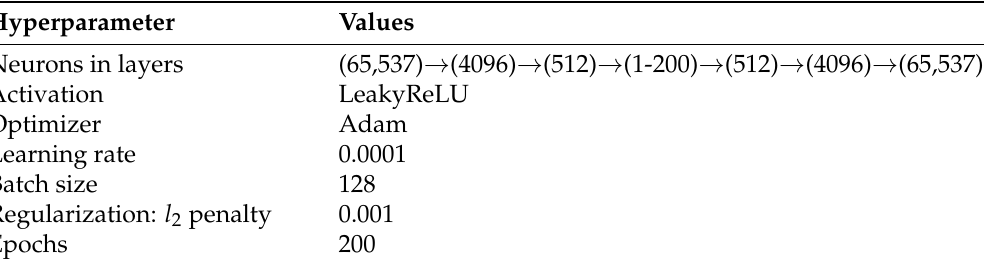
Figure 17. Classification accuracy values using SAE. Table 8. Hyperparameter of the